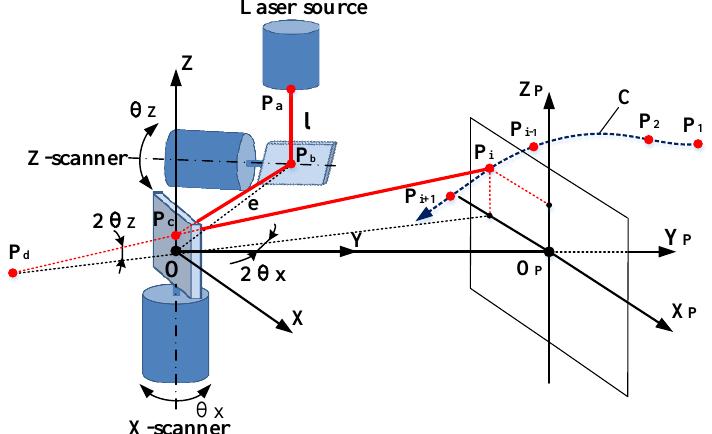
Figure 1. Principle of a photoelectric measurement system.